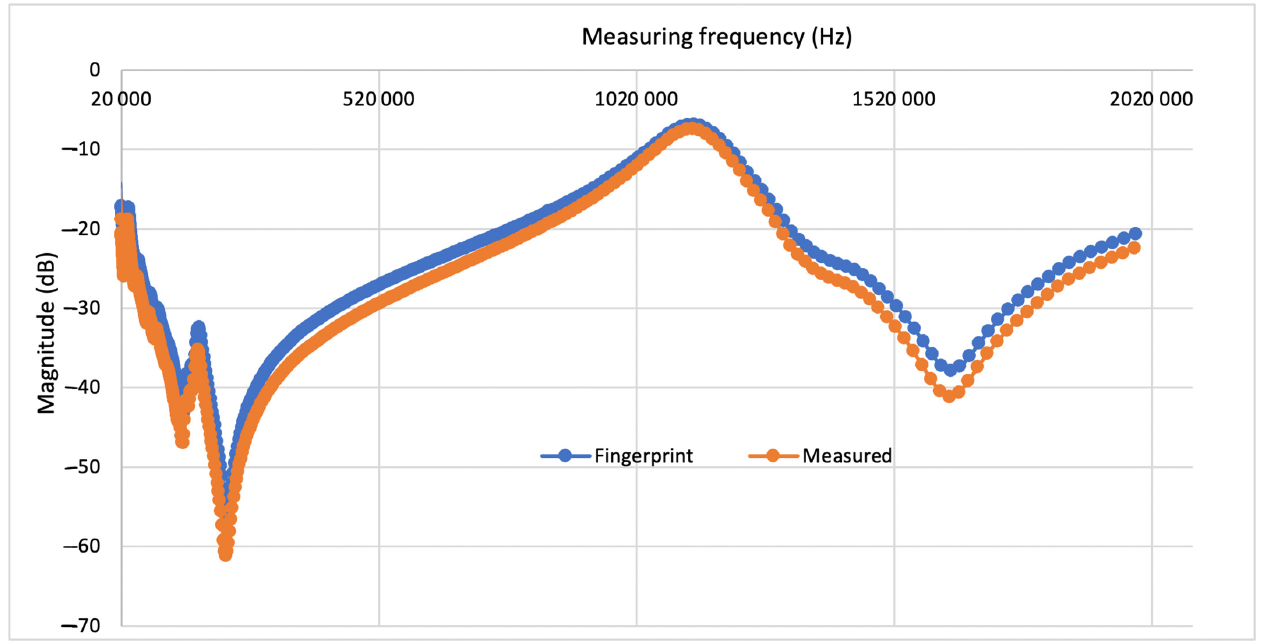
Figure 6. Case study 3: FRA Measurement.